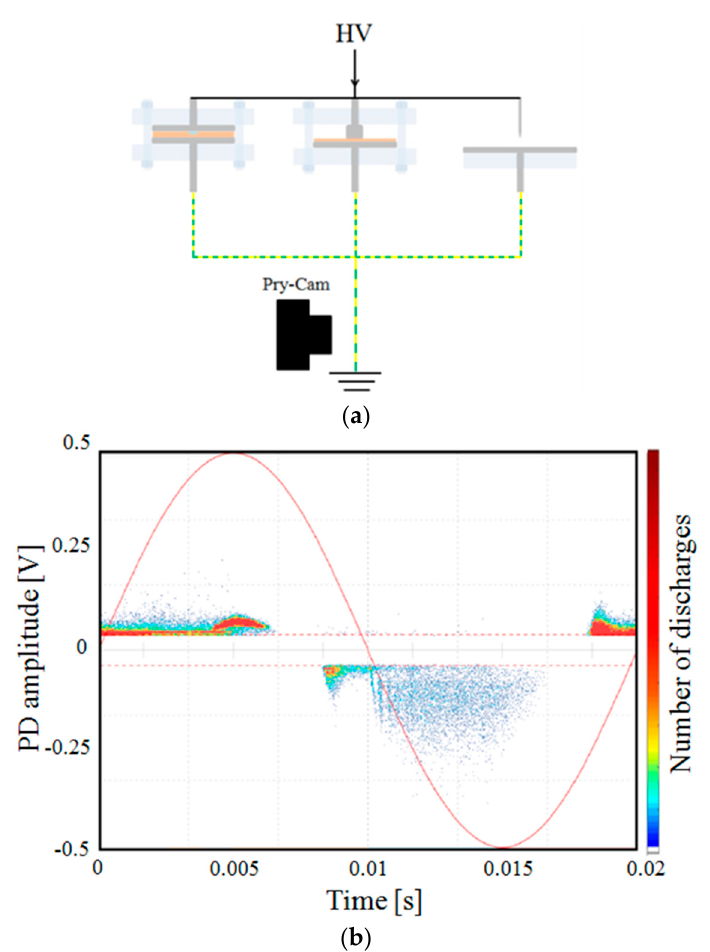
Figure 15. The simultaneous measurement of different PD signals. ( a ) The acquired PRPD pattern of three PD phenomena at 3.0 kV; ( b ) the three specimens under testing are parallel connected and the earth connections are joined among them before the PD sensor.